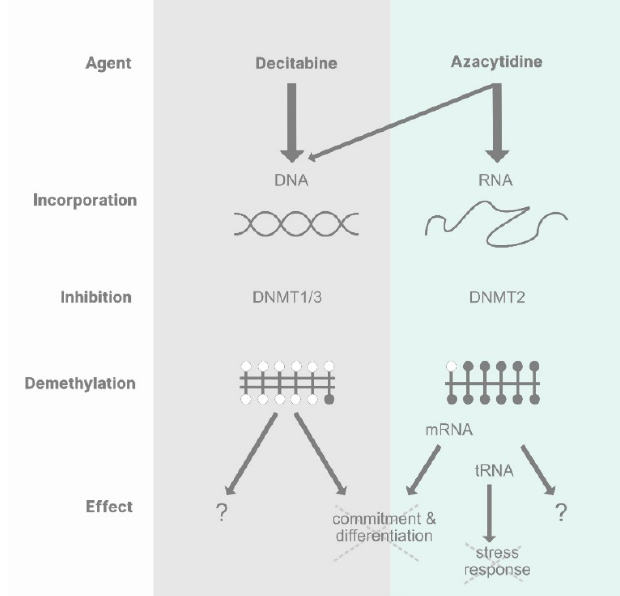
Figure 5. Decitabine: Intracellular processing into 5-aza-2 ′ -deoxycytidine triphosphate and incorporation into DNA results in inhibition of DNMTs 1 and 3. This leads to an overall decrease of DNA methylation and the reactivation of superficially silenced genes, allowing a proportion of neoplastic cells to exit their aberrant epigenetic state (see Figure 4). Azacytidine: a fraction of AZA is converted intracellularly into 5-aza-2 ′ -deoxycytidine triphosphate and follows the same fate as DEC. However, the majority becomes incorporated as 5-azacytidine into RNA, where it inhibits DNMT2. This leads to a specific decrease of RNA methylation at DNMT2 sites only. The specific hypomethylation of DNMT2 sites in mRNAs can interrupt positive feedback loops of transcription and reverse commitment decisions. The specific hypomethylation of DNMT2 sites in some tRNAs may make the cell more susceptible to stress by compromising their ability to raise a translational stress response.